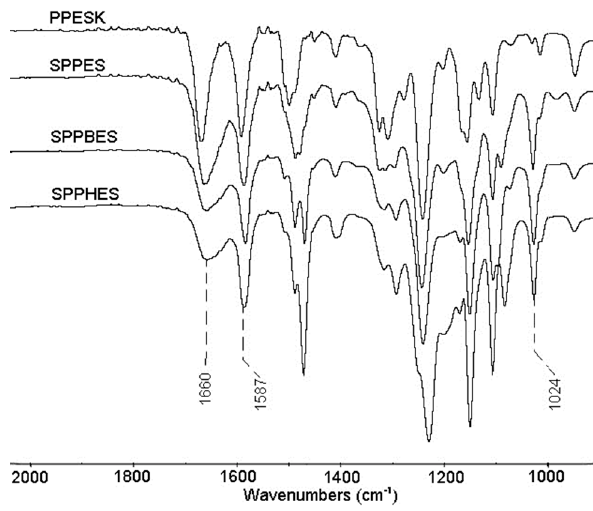
Figure 6. FTIR spectra of PPESK membrane and SPPES, SPPBES, and SPPHES composite membranes.